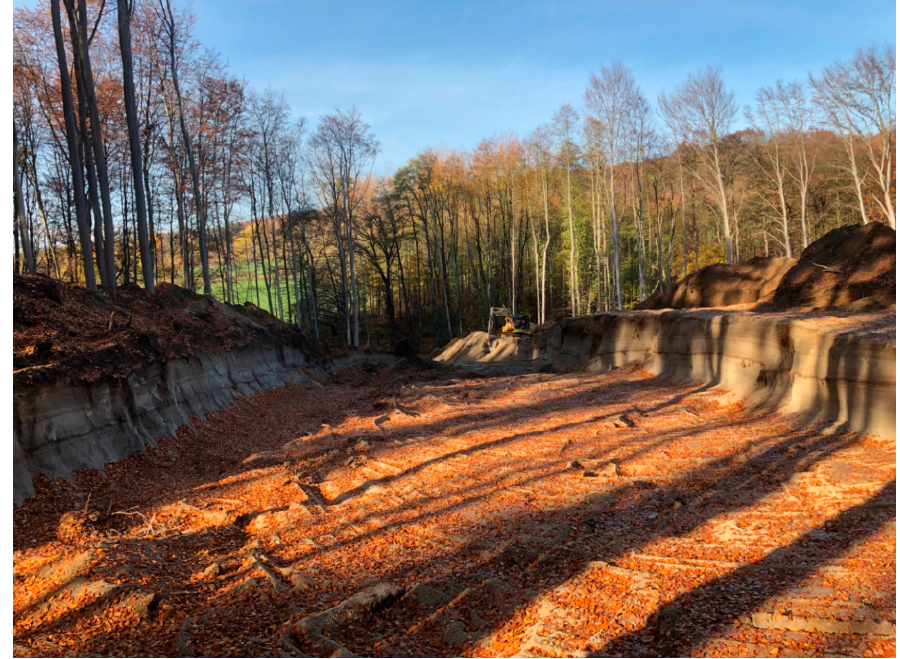
Figure 1. Pumice excavation in forest district Bendorf, 2018 (Photo: Alexander Klein). Material for later backfilling is visible on both sides.